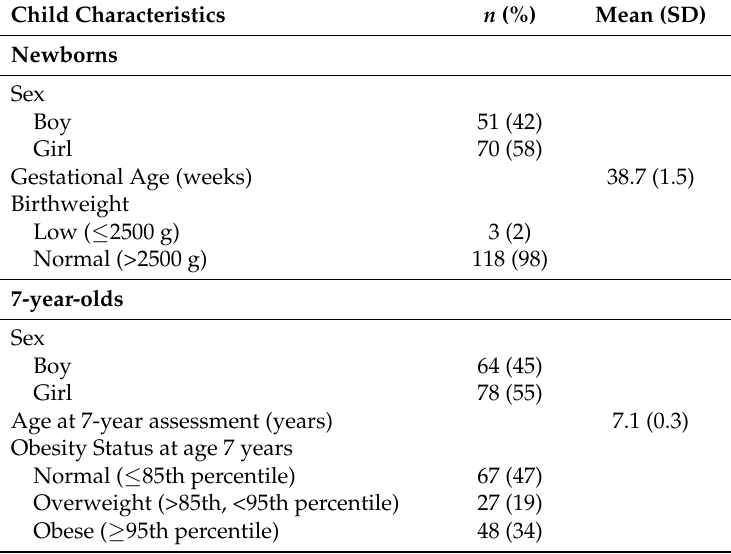
Characteristics of Center for Health Assessment of Mothers and Children of Salinas (CHAMACOS) children included in this